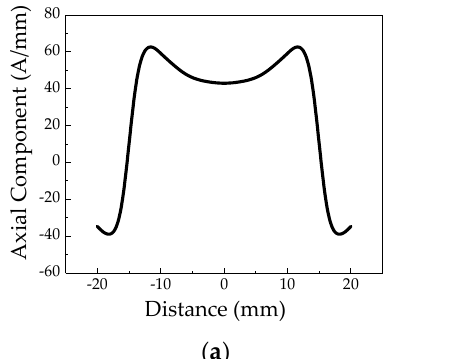
(b) Figure 4. The characteristics of weak magnetic signals at the crack: ( a ) axial component and ( b ) radial component. It can be seen from Figure 4 that the axial component of the weak magnetic at the crack has a maximum value near the crack tip, and a minimum value appears in the middle of the crack. The radial component of the weak magnetic at the crack has a peak and a valley at the crack tip. In order to study the characteristics of pipeline crack weak magnetic signals under different internal pressures, the internal pressures of 1 MPa~3 MPa are applied to the pipeline, and the weak magnetic signals and stresses at the crack are evaluated at an interval of 0.5 MPa, the stress changes at the crack tip are shown in Figure 5.